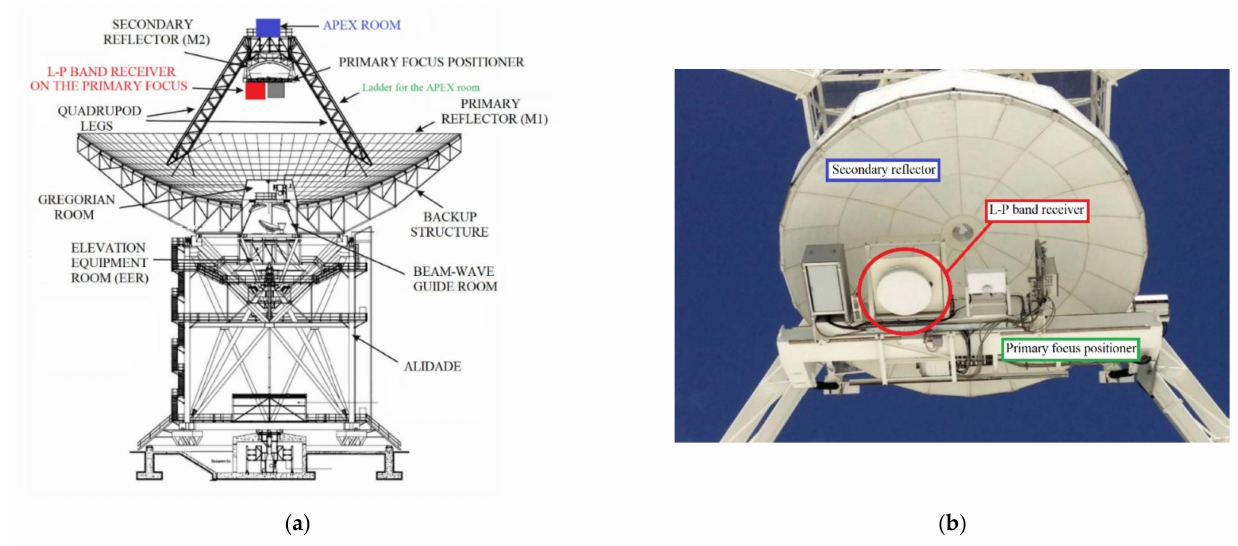
Figure 1. ( a ) Sketch of the Sardinia Radio Telescope (SRT), where the position of the L-P band receiver (primary focus of the telescope), the APEX room and the ladder for the APEX room, are highlighted; ( b ) Photo of the L-P band receiver installed on the primary focus of